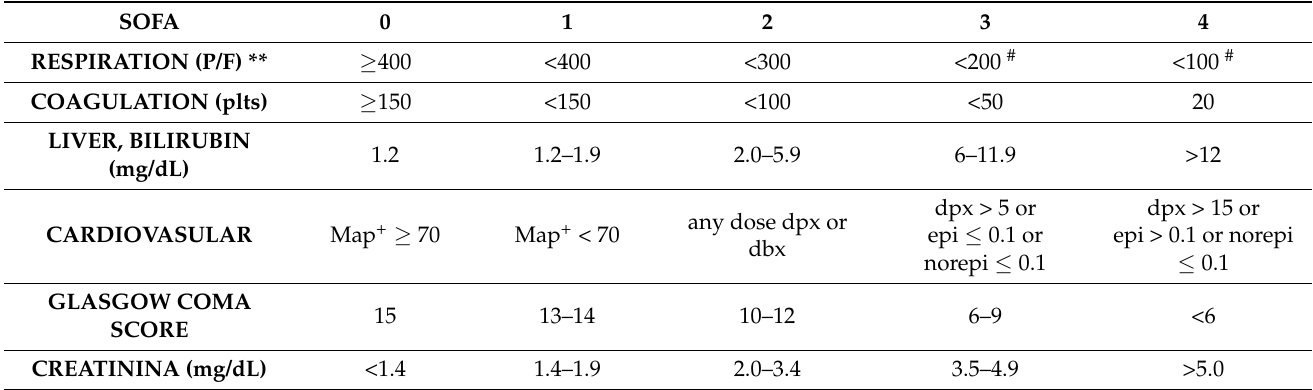
Table 2. Sequential Organ Failure Assessment (SOFA) Criteria. Adrenergic agents administered for at least one hour (doses given are in µ g/kg/minute). Norepi = norepinephrine; dpx = dopamine; dbx = dobutamine; epi = epinephrine. ** PaO2/FiO2 = arterial partial pressure of oxygen/fraction of inspired oxygen + MAP = mean arterial pressure # With respiratory